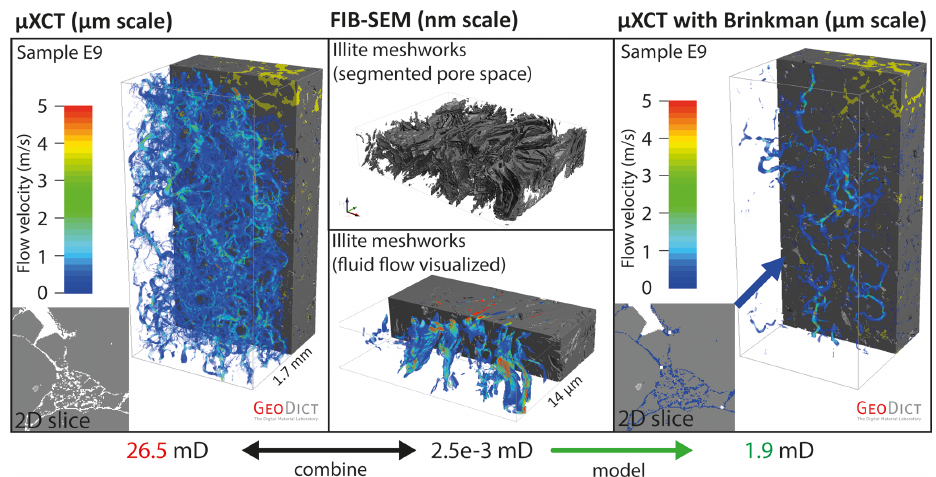
Figure 7. Workflow for microporous domain modelling combining FIB-SEM nanoporosity with µXCT scans. Sample E9 of the aeolian layer with well-distributed flow paths was selected for visualization. Upon the modelling of the microporous domains, the total fluid-flow velocity decreases. Displayed simulated permeabilities include the mean values of five samples with the best distribution of percolation paths. Fluid-flow velocities close to zero are